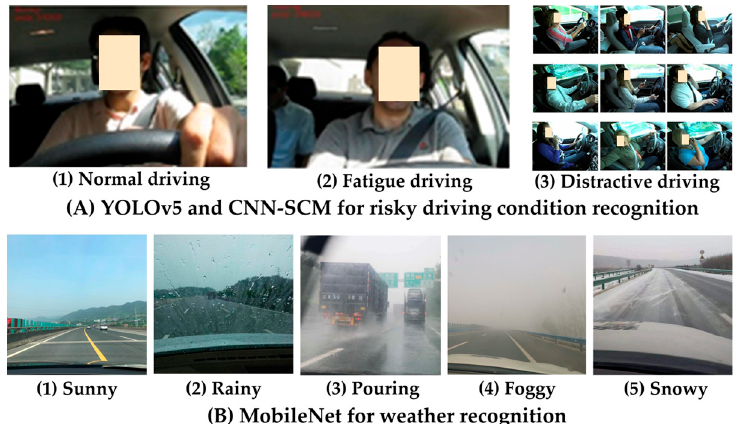
Figure 1. Recognitions for risky driving and weather conditions from dashboard camera.